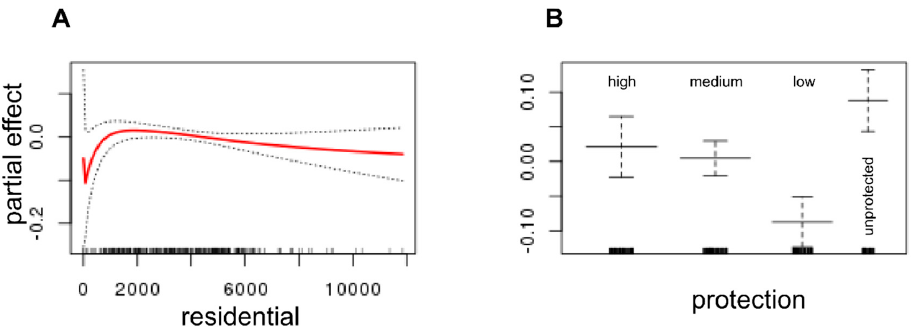
Figure 12. Partial effects in the best gam model for temporal trend in annual hydroperiod corrected for precipitation (Kendall’s tau) for natural water bodies. ( A ) Residential = smoothing spline of log distance to residential areas; ( B ) protection = protection level (factor, four levels).